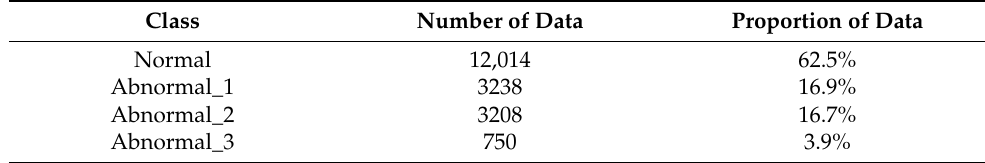
Table 1. Proportion of